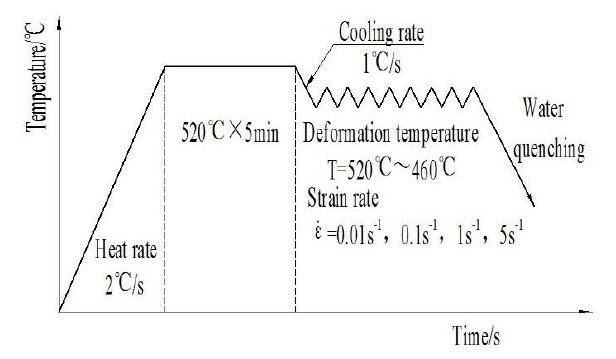
Figure 2. The hot-deformation process diagram.